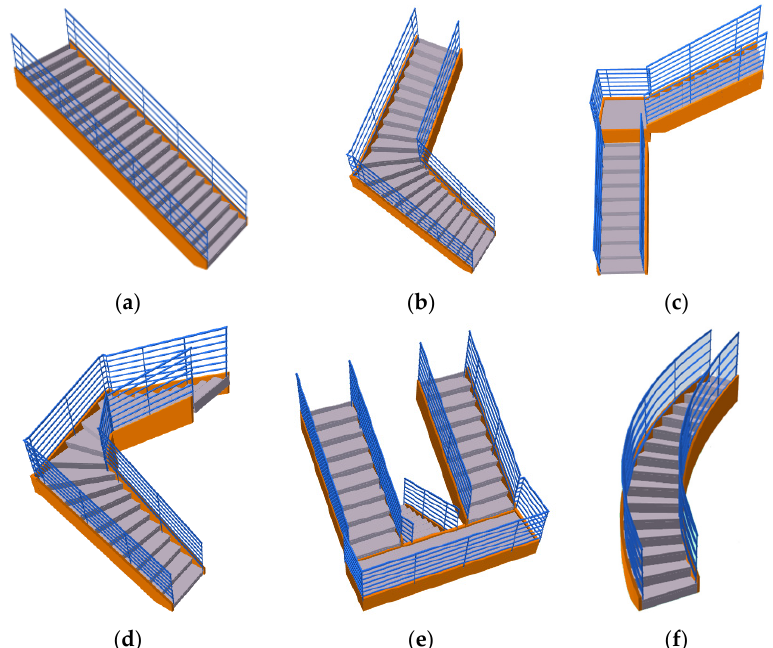
Figure 13. Stairs to be evaluated: ( a ) straight stair, ( b ) turn stair, ( c ) L-style stair, ( d ) n-style stair, ( e ) m-style stair, and ( f ) spiral stair.